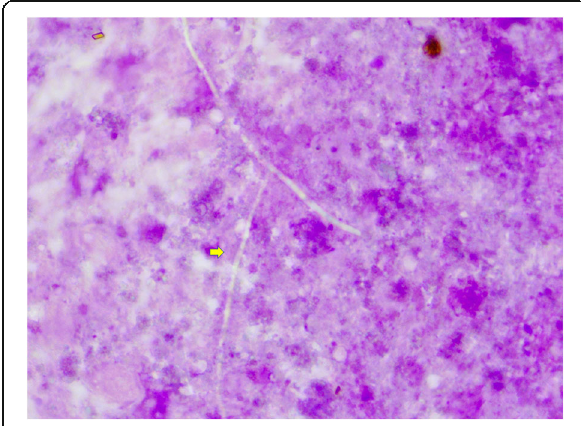
Fig. 2 Rapid onsite staining showing the presence of negatively stained acute angle branched hyphae (arrow) along with inflammatory background. (Tol Blue, ×